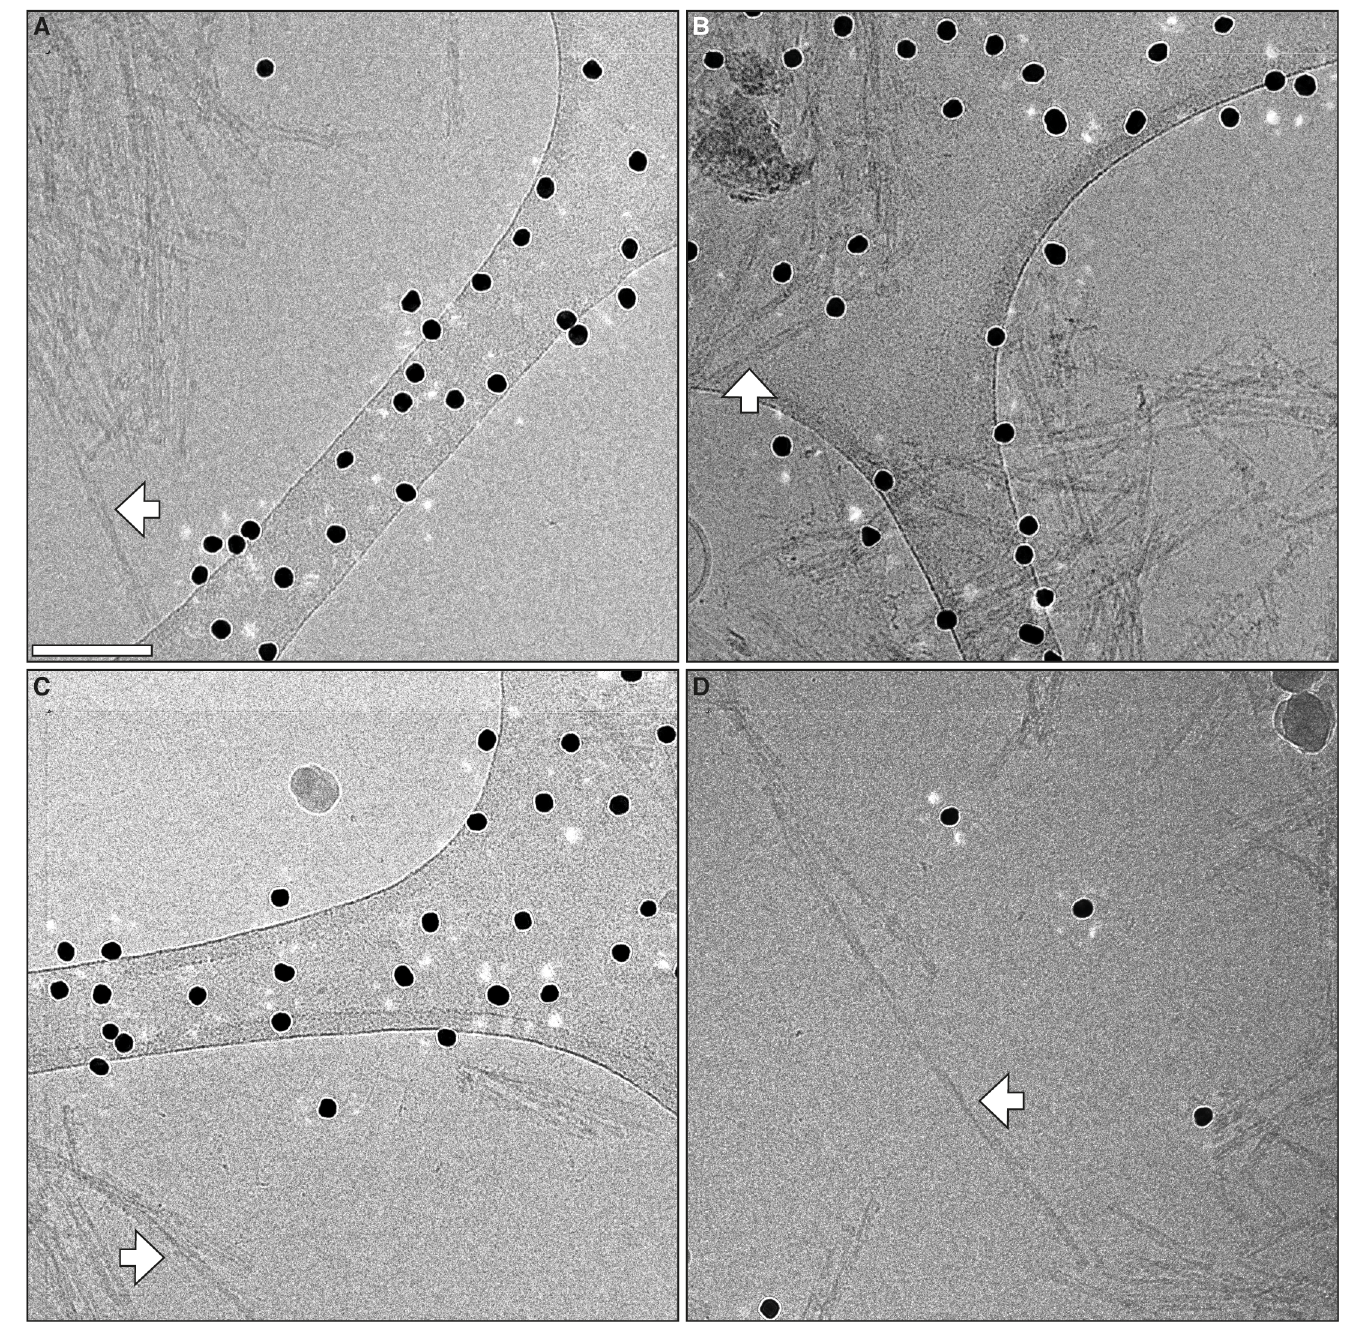
Fig 4. Additional cryo-EM micrographs of GPI-anchorless prion fibrils. Electron micrographs showing representative GPI-anchorless prion fibrils, including four isolated fibrils that were subsequently analyzed by image processing (white arrows). The labels ( A to D ) correspond to the lettering in the 3D fibril reconstruction figures ( vide infra ). Black dots originate from fiducial gold that was added for tomographic studies. Scale bar, 100 nm.